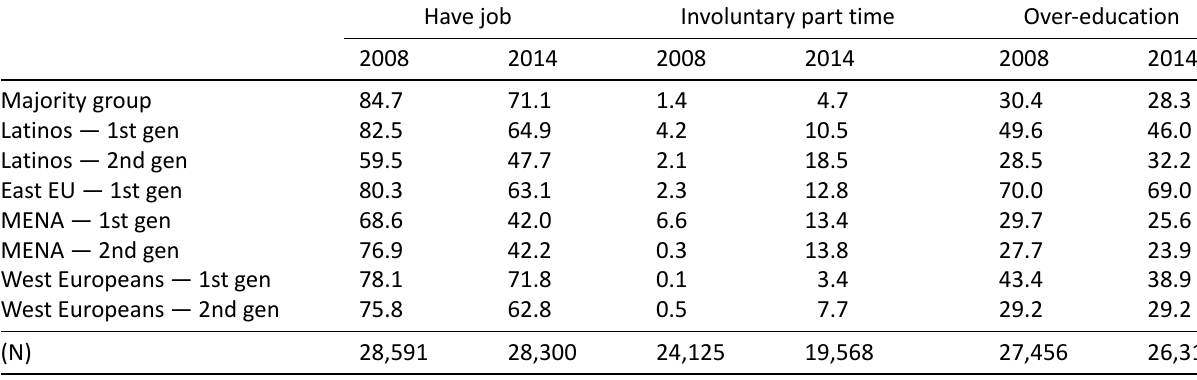
Table 3. Labour market outcomes by ethnicity and generation in 2008 and 2014 (males). Have job